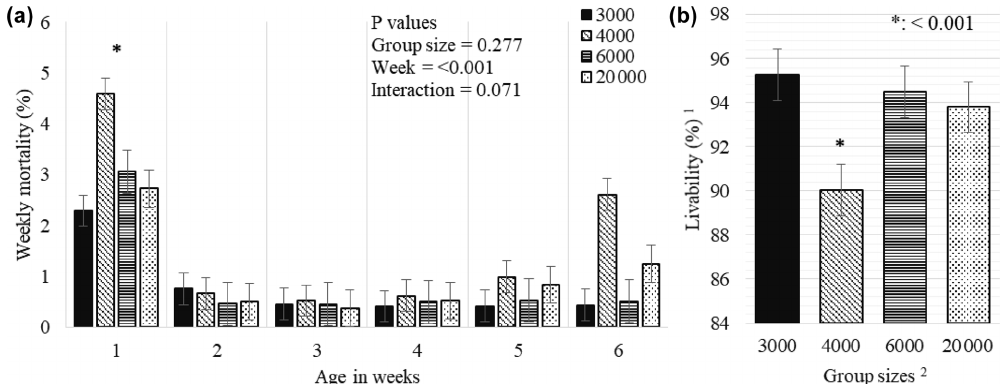
Figure 5. Weekly least square means and standard error ( ± SE) of mortality (a) and total livability (b) percentages of chickens reared in varying group sizes. 1 Livability was determined as in Eq. (2). 2 The 3000, 4000, 6000, and 20000 numbers represent the number of chickens in the each group size. ∗ : < 0.001 represents a level of significance for weekly total mortality (a) among weeks and total livability (b) among treatments during 6 weeks of